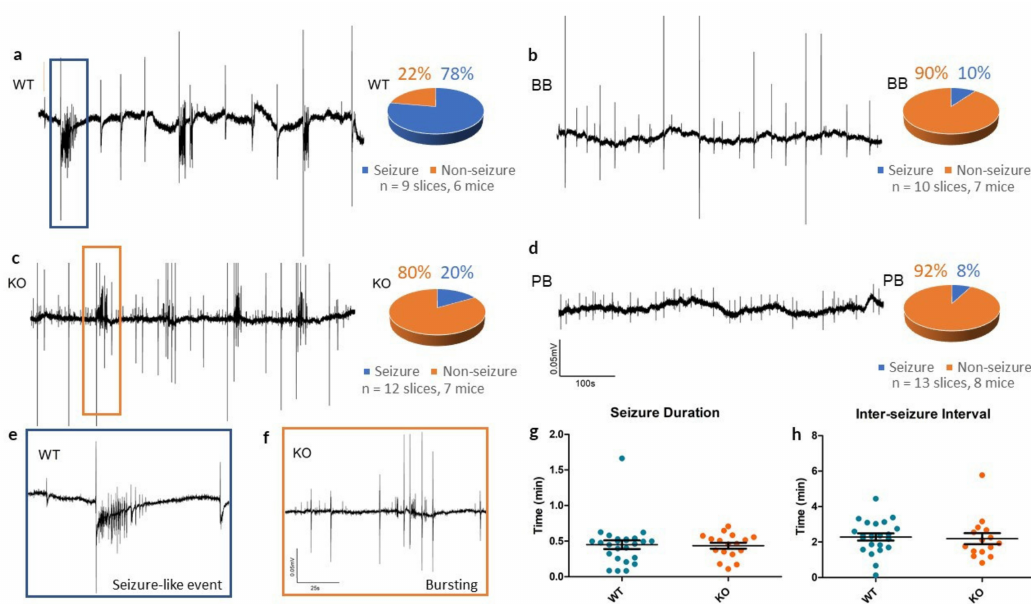
Figure 3. Seizure-like events in vitro in WT, KO, BB (Brilliant Blue-FCF-treated) and PB (probenecid-treated) groups. ( a – d ) Sample recordings of local field potentials from each of the four experimental groups, along with pie charts summarizing seizure incidence with 4-AP. Recordings from WT mice often had one or more seizure-like events (78%), whereas KO, BB and PB mice often had only small synchronous bursting events (20%, 10% and 8% respectively). All traces share the calibrations defined in ( d ). ( e , f ) High-energy activity in the WT and KO traces is zoomed in to reveal a SLE in the WT slice and bursting in the KO slice, indicative of the most common outcomes to 4-AP for each group. Both traces share the calibrations defined in ( f ). ( g,h ) Comparison of seizure duration and inter-seizure interval of SLEs in both WT and KO slices. Despite a reduced incidence, once initiated, KO SLEs remained similar to WT SLEs. Table 1. Incidence of seizure-like events (SLEs) in vitro following perfusion of cortical slices with 100 µ M 4-AP. 12 slices from 7 KO mice had fewer 4-AP-induced SLEs than in the 9 slices from 6 of their WT counterparts ( p = 0.0051, Chi-squared). Mice treated with Brilliant Blue-FCF (7 mice, 10 slices) or probenecid (8 mice, 13 slices) before 4-AP exposure also had fewer instances of at least one SLE